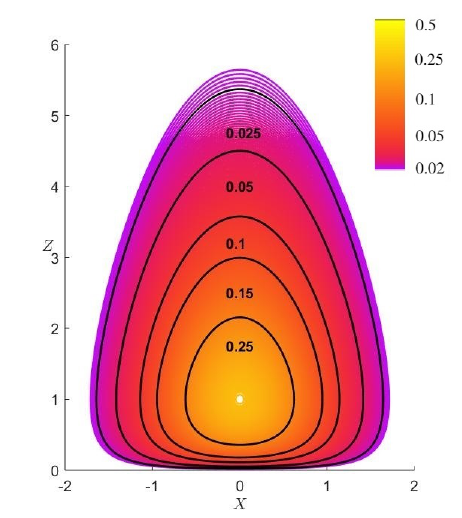
Figure 5. The dimensionless stream functions (or angular momentum surfaces) ψ = ψ / v 0 r 2 labels given by Z = z